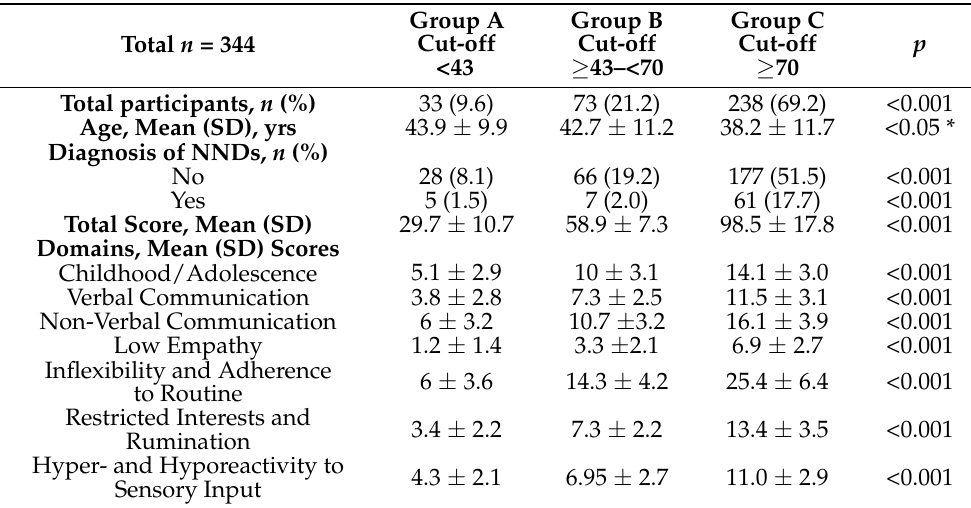
Table 3. Classification of the respondents according to the adult autism subthreshold spectrum (AdAS spectrum score) and comparison of the self-reported scores in the AdAS spectrum total score and